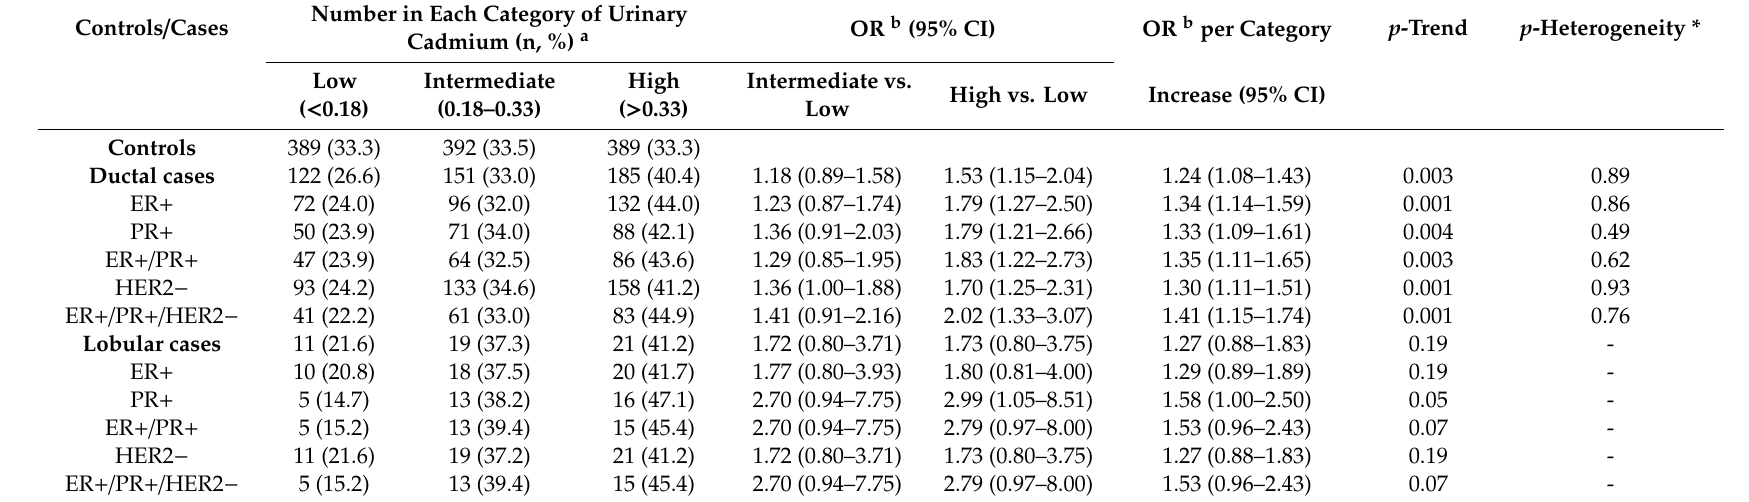
Table 3. Odds ratios (ORs) and 95% confidence intervals (CIs) for the association of creatinine-adjusted urinary cadmium (kg × 10 − 9 / kg × 10 − 3 creatinine) with invasive ductal and invasive lobular breast